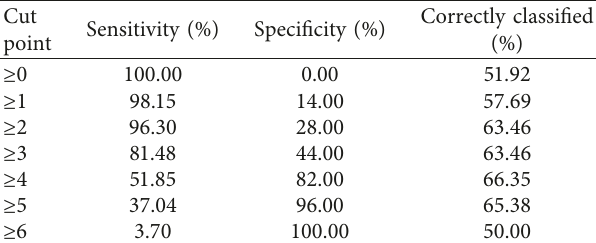
Table 7: Diagnostic accuracy and cut-offs for